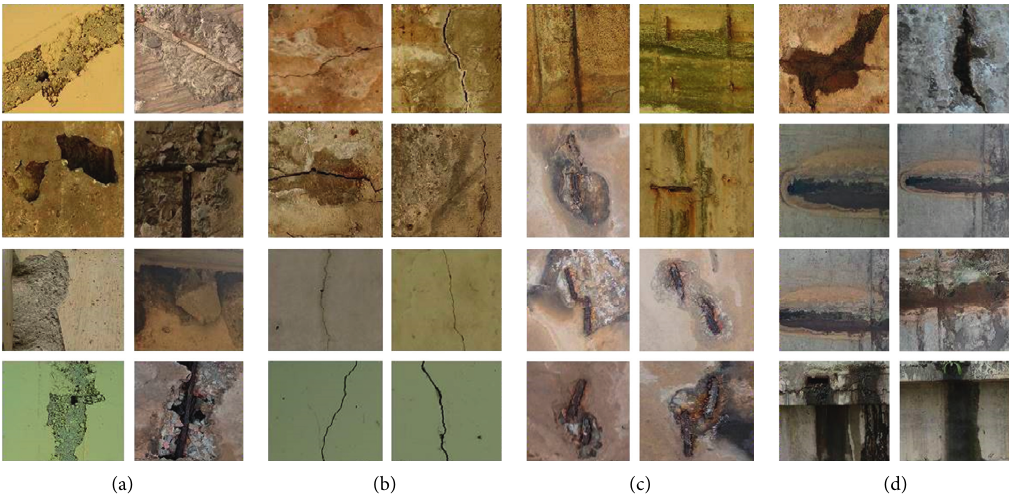
Figure 13: The examples of four bridge defect types: (a) concrete spalling, (b) crack, (c) reinforcing bar, and (d) water